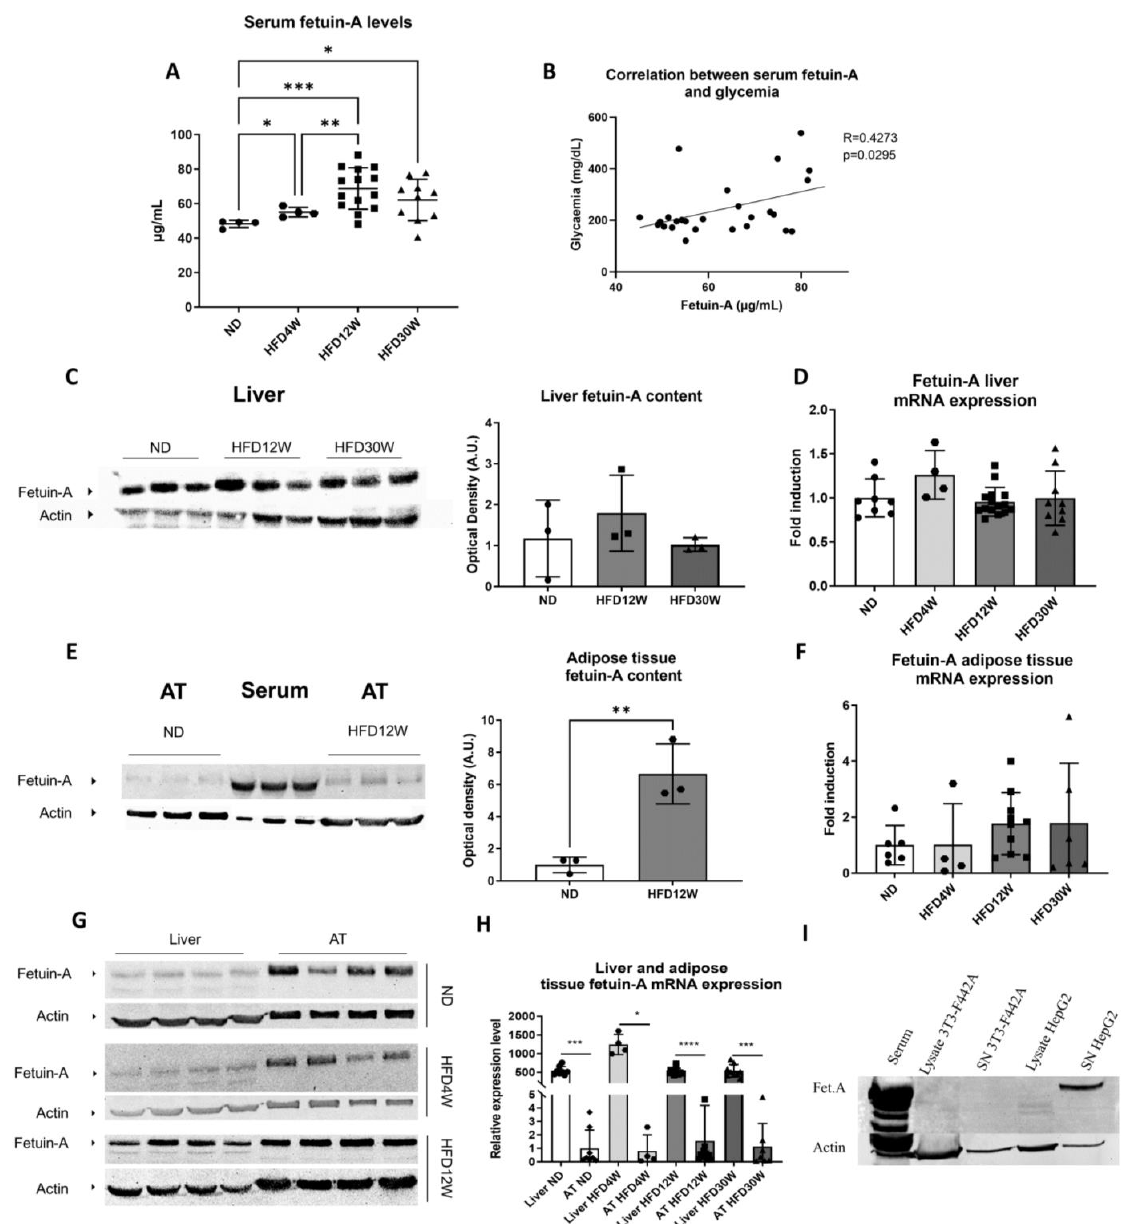
Figure 3. Elevation of fetuin-A levels in relation to insulin resistance and characterization of levels in serum, liver, and adipose tissue in mice. Serum fetuin-A levels in normal diet (ND) and high fat diet mice for 4 (HFD4W), 12 (HFD12W), or 30 weeks (HFD30W). n = 4–12/group ( A ). Correlation between serum fetuin-A levels and blood glucose levels ( B ). Western blots and corresponding quantifications based on averages of actin (endogenous control) corrected fetuin-A labelling intensity ratios for liver ( C – G ), adipose tissue (AT), and serum ( E , G ). Expression of fetuin-A (messenger RNA) in liver ( D , H ) or adipose tissue ( F , H ) of foz − / − mice on normal (ND) or high fat diet for 4, 12, or 30 weeks (HFD4W, HFD12W, HFD30W). n = 4–12/group. * p < 0.05, ** p < 0.01, *** p < 0.001, **** p < 0.0001. Fetuin-A content in lysates and supernatants (SN) of 3T3-F442A (adipocytes) or HepG2 (hepatocytes) cells ( I